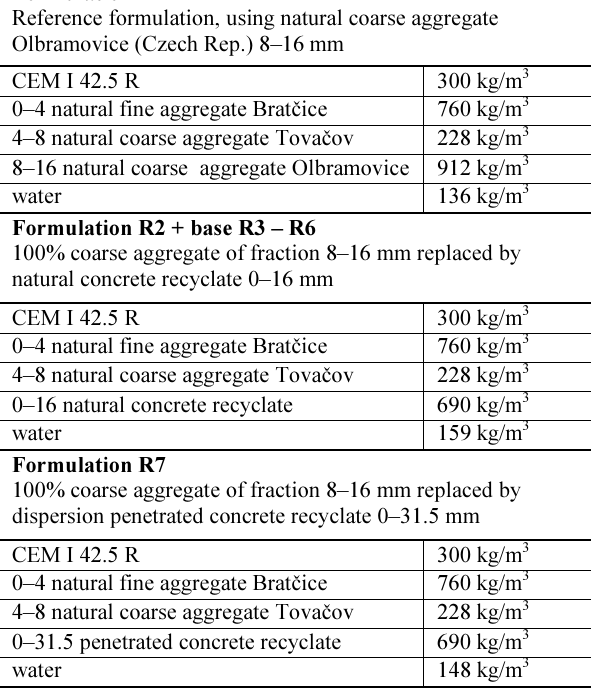
Table 2. Formulation of concrete